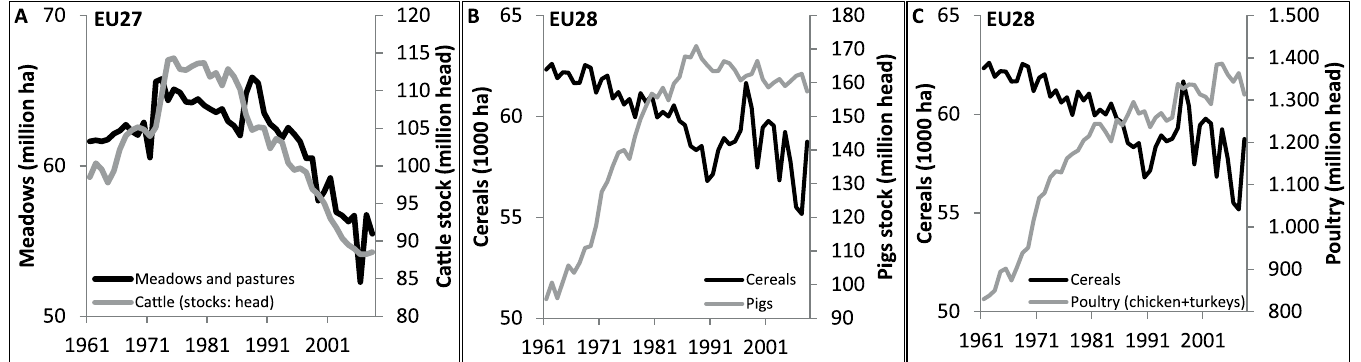
Fig 4. A: Correlation between cattle stock and area of permanent meadows and pastures in Europe, EU27 (excl. Romania), correlation coefficient: 0.86. B: Correlation between pigs stock and area of cereal production in Europe, correlation coefficient: − 0.83. C: Correlation between poultry stock (chicken and turkeys) and area of cereal production in Europe, correlation coefficient: − 0.86. 1961 – 2008, [21,34].